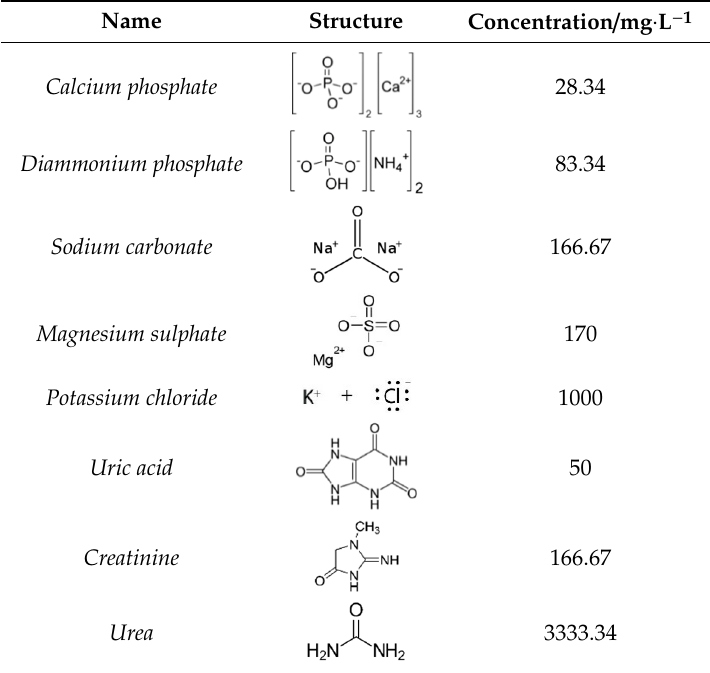
Table 1. Compounds and concentrations present in the synthetic urine.